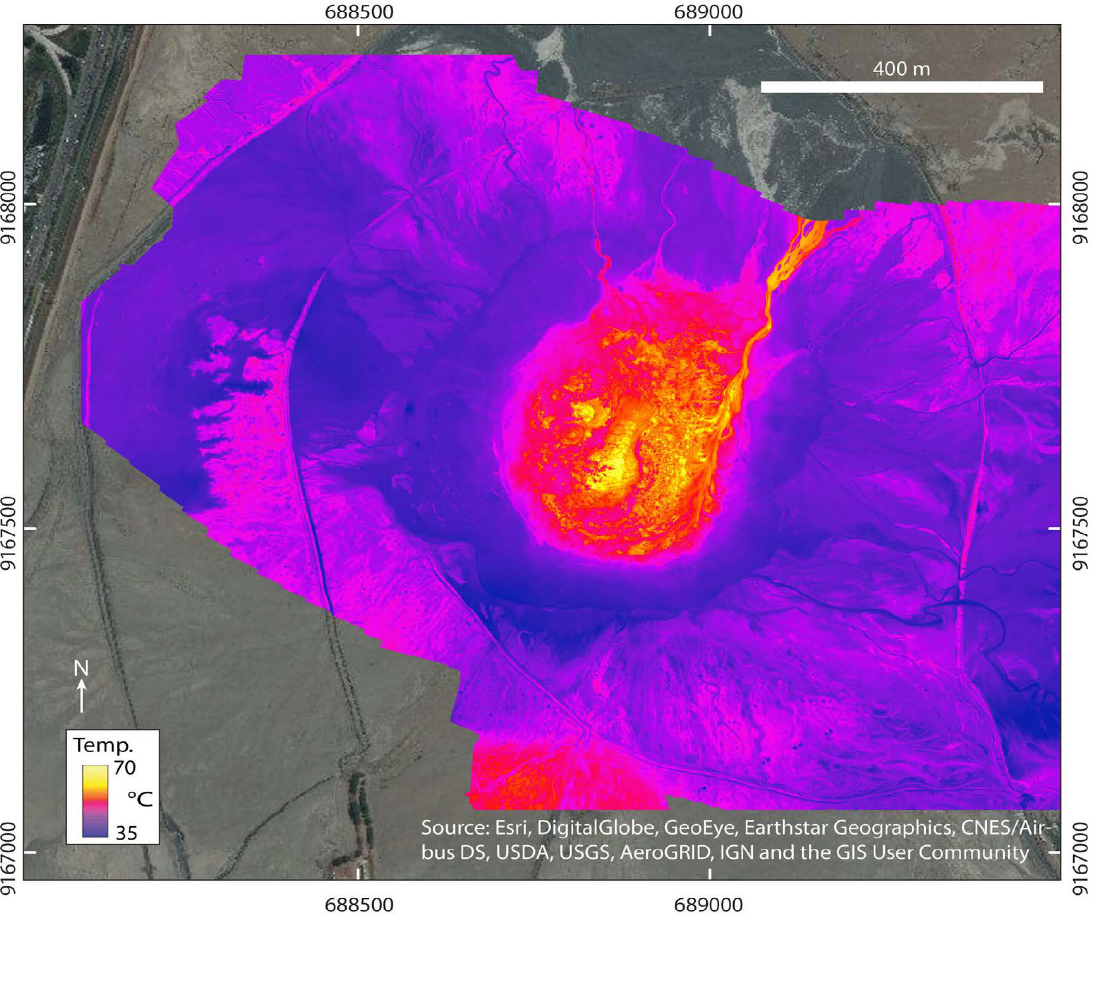
Figure 13: A thermal orthomosaic of the LUSI mud volcano collected by a DJI Matrice 210 in 2018, superimposed over web-sourced visible-wavelength imagery. The thermal data (approximately 445 images) were collected with a DJI Zenmuse XT from ~200 m above ground. The final orthomosaic (DOI: 10.5069/G9Q81B6D) has a spatial resolution of 0.3 m, and shows the ~300-m-diameter hot central area surrounding the vent region, and associated warm outflow